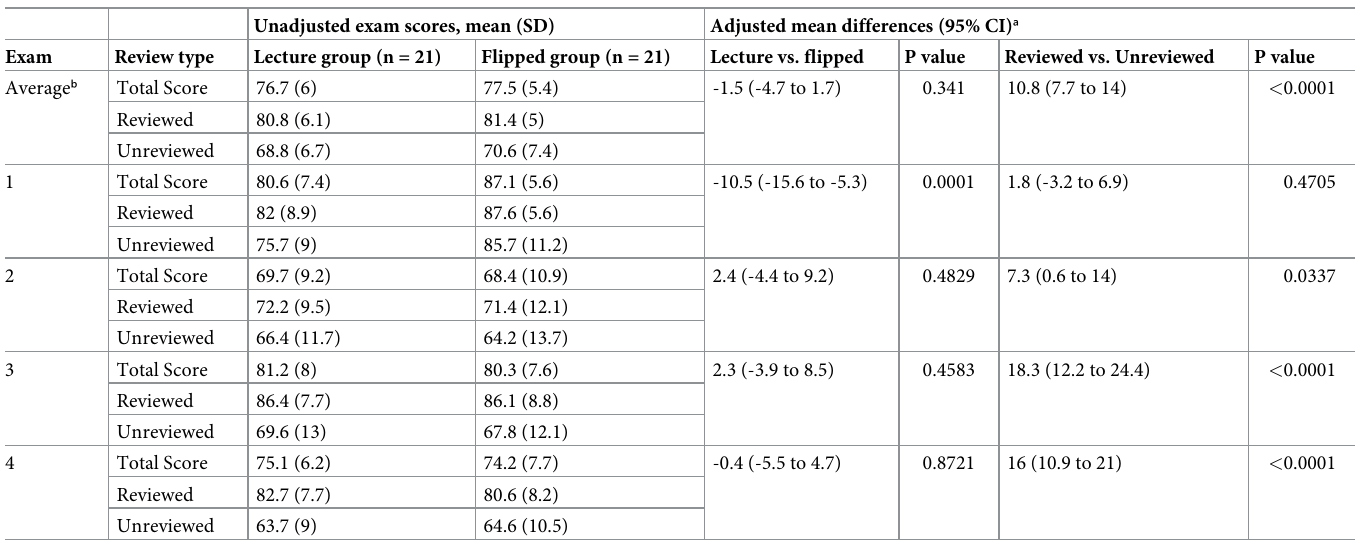
Table 3. Exam scores in lecture and flipped